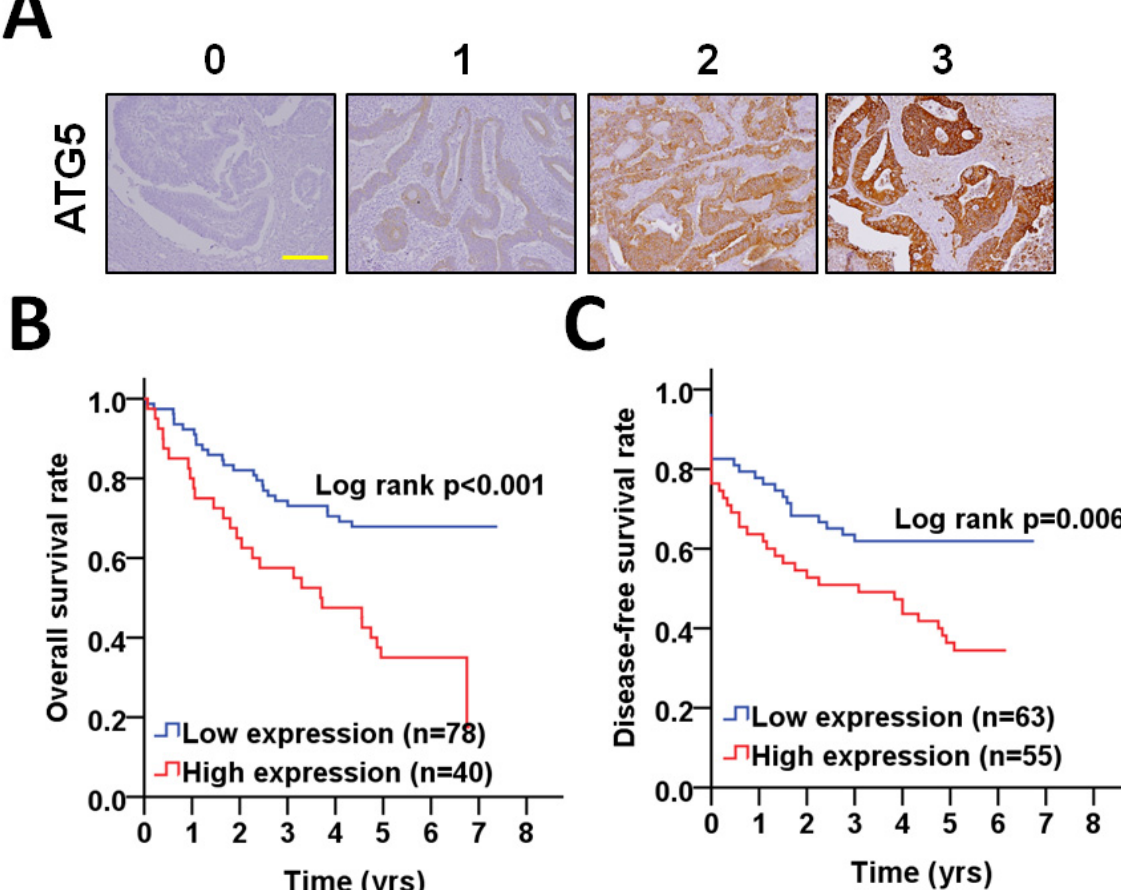
Figure 1. The correlation of the ATG5 protein level on tumor tissues with the overall survival and DFS in patients with CRC. ( A ) The protein level of ATG5 in tumor tissues were determined by immunohistochemistry and the staining intensity was categorized into four degrees as representative images. Scale bar: 200 μ m. ( B ) The association of higher (red) or lower (blue) ATG5 protein level on tumor tissues with the overall survival of CRC patients was analyzed by Kaplan–Meier plots. ( C ) The association of higher (red) or lower (blue) ATG5 protein level on tumor tissues with DFS of CRC patients was examined by Kaplan–Meier analysis. The cutoff values to differentiate the high or low ATG5 protein levels in tumor tissues were based on the receiver operating characteristic (ROC) curve.